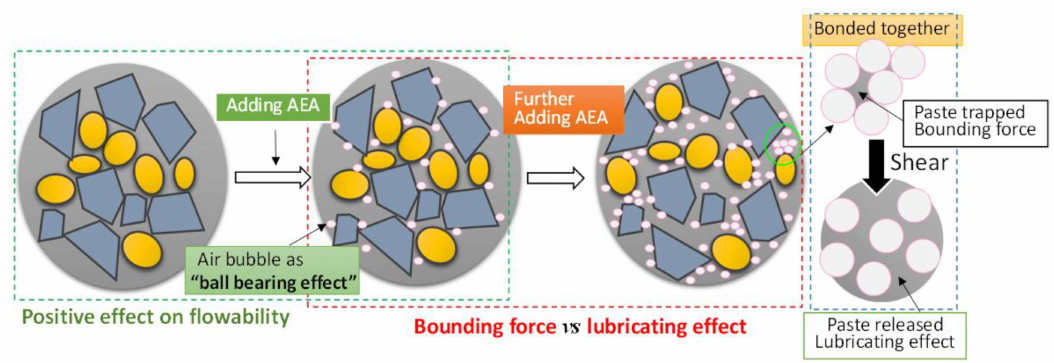
Figure 11. Schematic of the effect of air bubble on flowability of WET